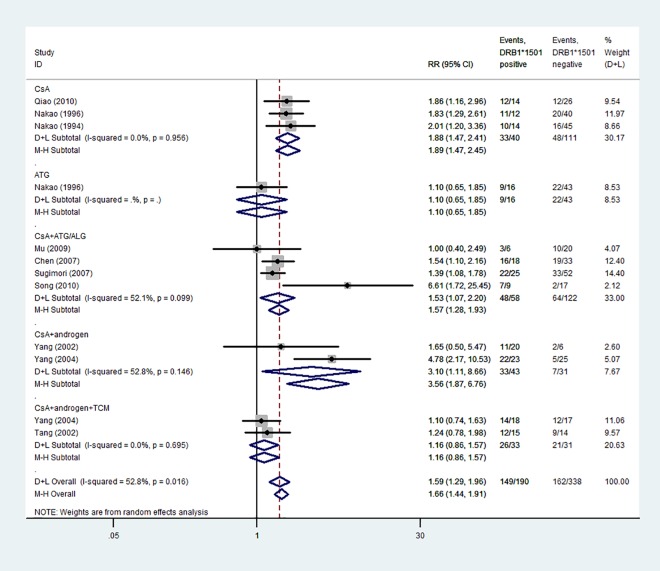
Forest plot of relative ratios for overall response rate between HLA-DRB1*15:01+ and HLA-DRB1*15:01− patients.